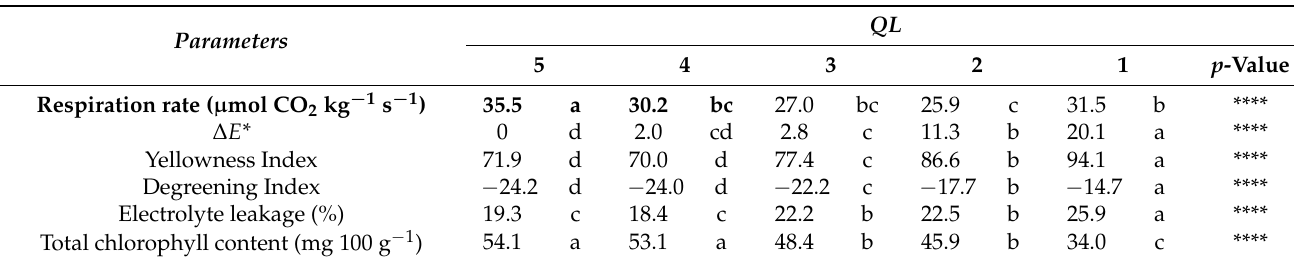
Table 3. Respiration rate, color parameters, electrolyte leakage and total chlorophyll content in rocket leaves stored at 10 ◦ C, at each quality level